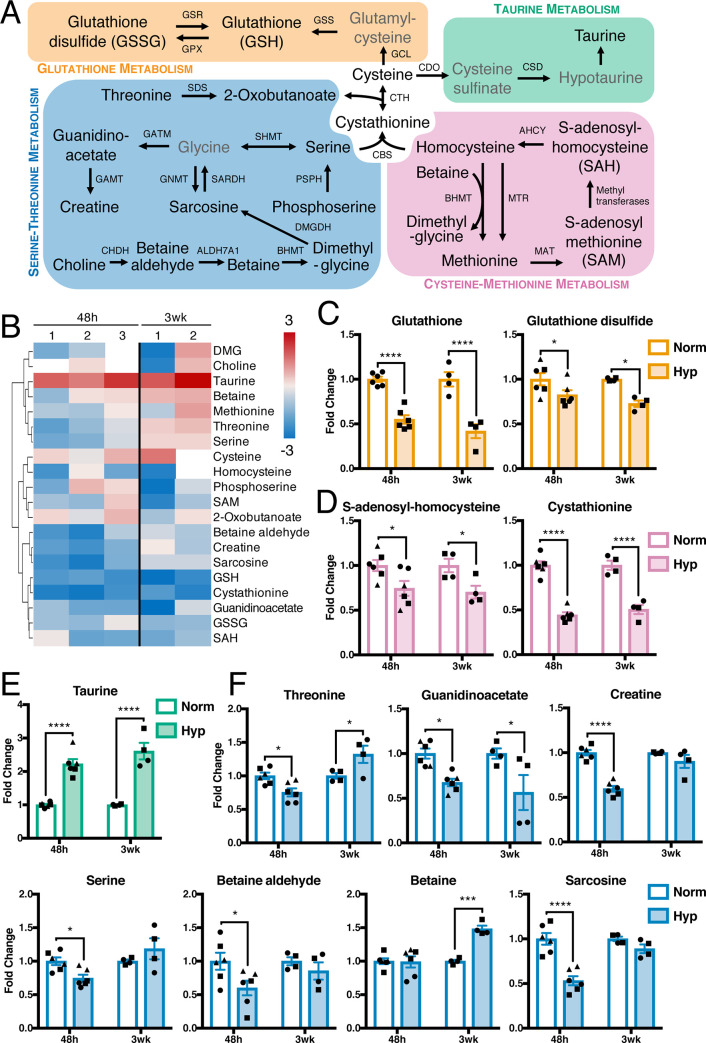
Interconnected pathways of serine and cysteine metabolism are altered by hypoxia.(A) Metabolites and enzymes in serine-threonine, glutathione, taurine, and cysteine-methionine metabolism. Metabolites in gray not measured or detected. (B) Fold change metabolite abundance over normoxia control for metabolites from pathway in A detected in more than one sample. White space indicates metabolite not detected. (C-F) Significantly altered metabolites from B. Significance by two-way ANOVA. All error bars represent SEM, different symbols represent biological replicates. *, p < 0.05; ***, p < 0.001; ****, p < 0.0001. Enzyme abbreviations: AHCY, Adenosylhomocysteinase; ALDH7A1, aldehyde dehydrogenase 7 family member A1; BHMT, betaine—homocysteine S-methyltransferase; CBS, cystathionine beta-synthase; CDO, cysteine dioxygenase; CHDH, choline dehydrogenase; CSD, cysteine desulfurase; CTH, cystathionine gamma-lyase; DMGDH, dimethylglycine dehydrogenase; GAMT, guanidinoacetate N-methyltransferase; GATM, glycine amidinotransferase; GCL, glutamate cysteine ligase; GNMT, glycine N-methyltransferase; GPX, glutathione peroxidase; GSR, glutathione-disulfide reductase; GSS, glutathione synthetase; MAT, methionine adenosyltransferase; MTR, methionine synthase; PSPH, phosphoserine phosphatase; SARDH, sarcosine dehydrogenase; SDS, serine dehydratase; SHMT, serine hydroxymethyltransferase. Metabolite abbreviations: DMG, dimethylglycine; GSH, glutathione; GSSG, glutathione disulfide; SAH, S-adenosylhoomocysteine; SAM, S-adenosylmethionine.